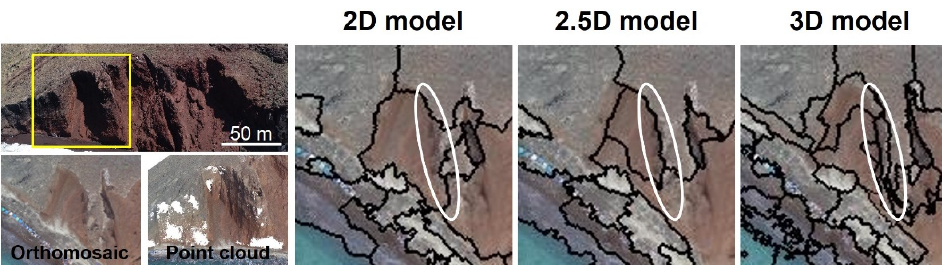
Figure 9. A characteristic example of the different outputs produced by 2D, 2.5D, and 3D segmentations for the delineation of steep sub-elements such as the flanks of a landslide. The white ellipse delineates the flank and part of the scarp, and the increasing level of important detail defined as the dimensions of the analysis increase.